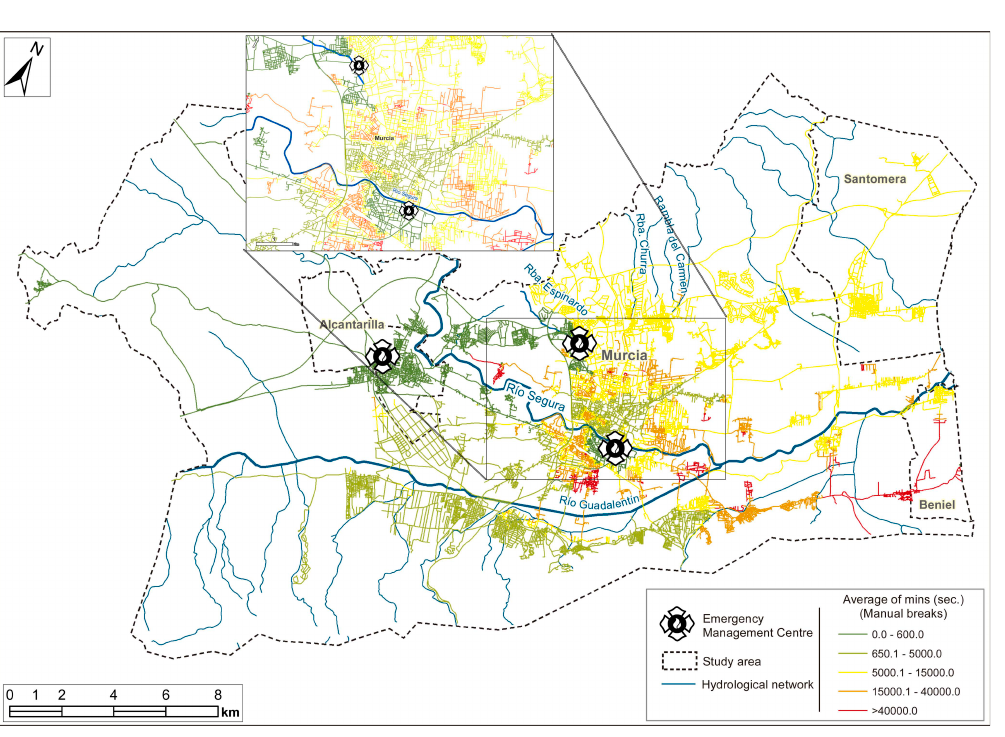
Figure 5. Map of present network